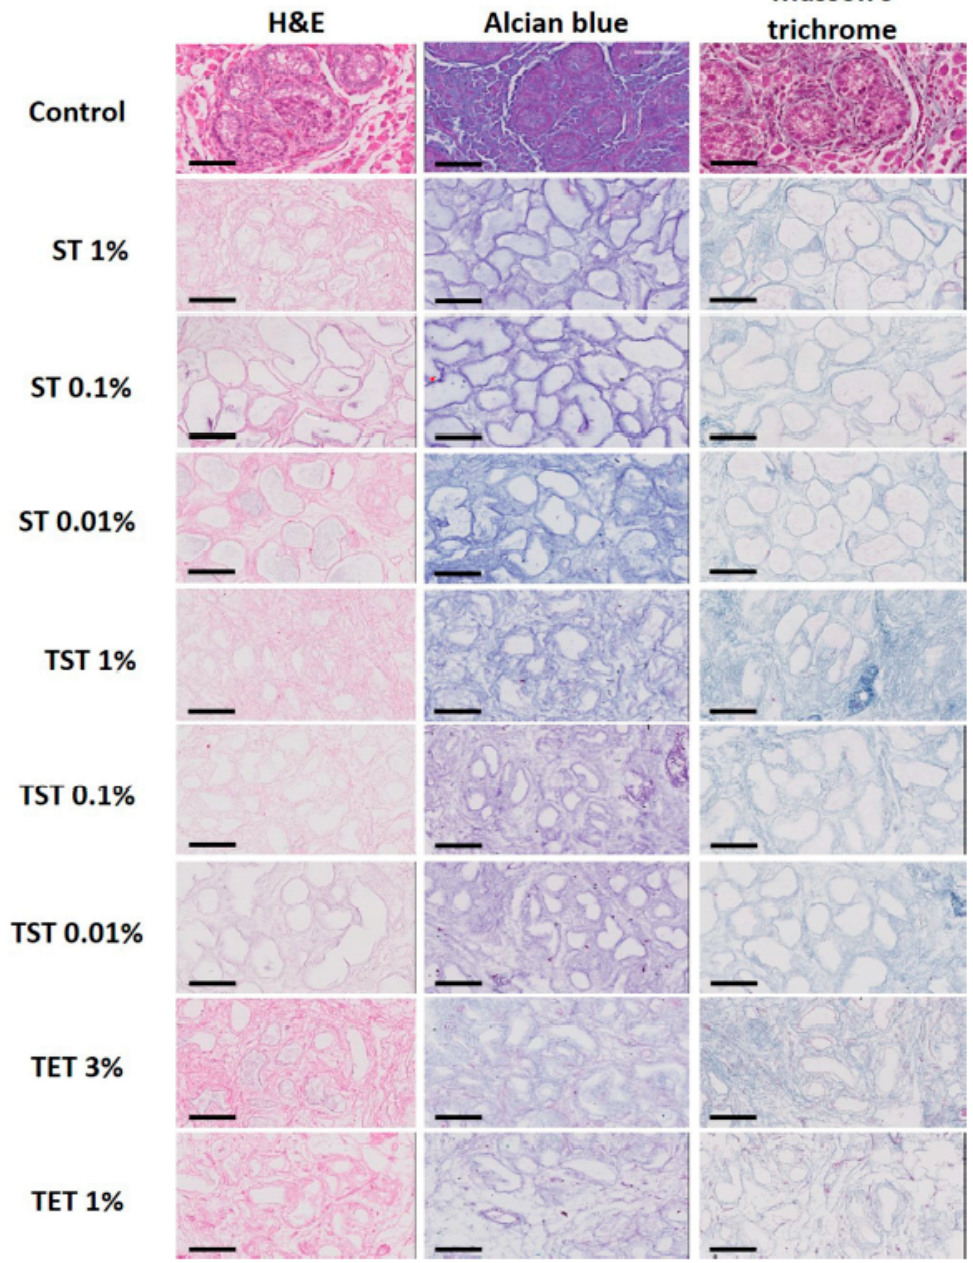
Figure 3. Histological staining of native tissue and DT with different protocols in different conditions. H and E, Alcian blue and Masson’s trichrome staining evidenced preservation of structure, GAGs and collagen respectively. Scale bar = 70 µm.